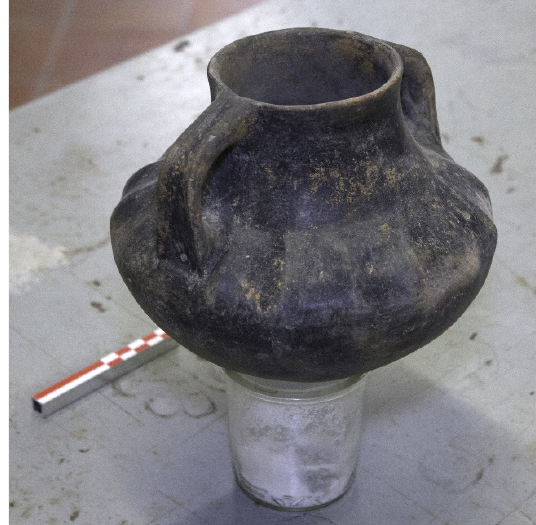
Fig. 8 An example of shoot with polarized light of a little amphora from Tomb 596.